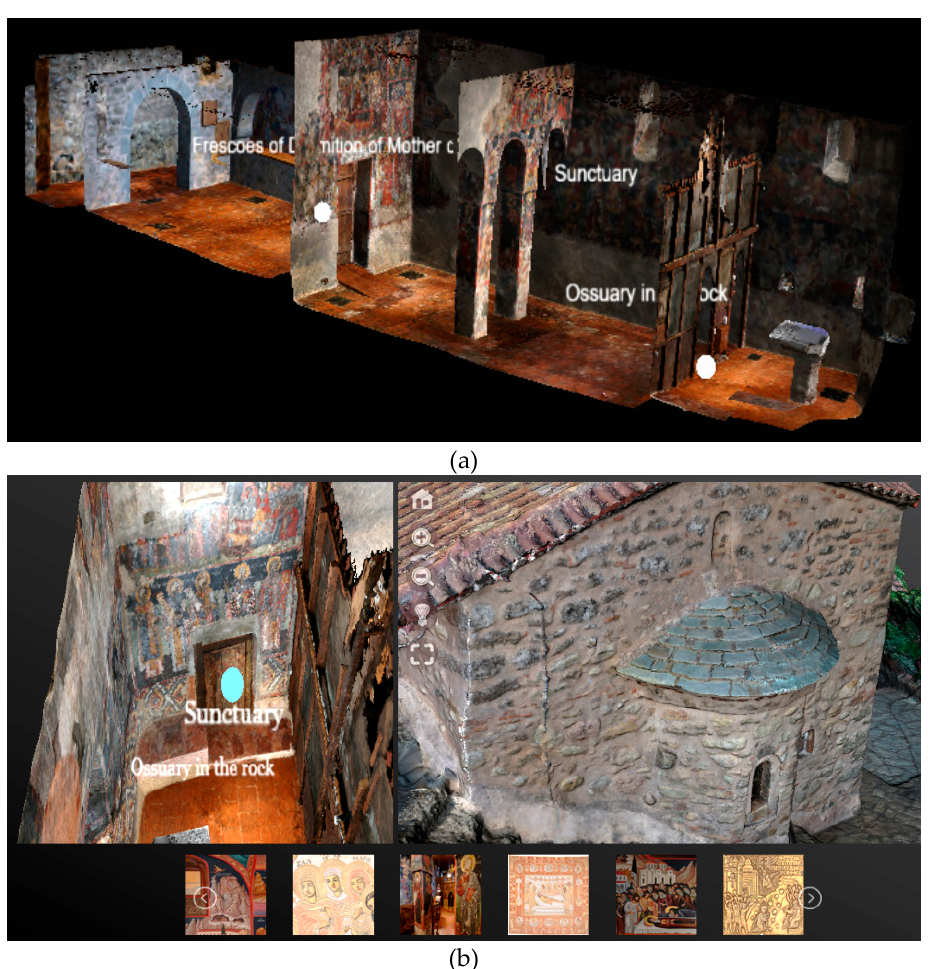
Figure 14. ( a ) Text and graphic labels on the interior of the church and ( b ) the result of a click event to a point of interest .